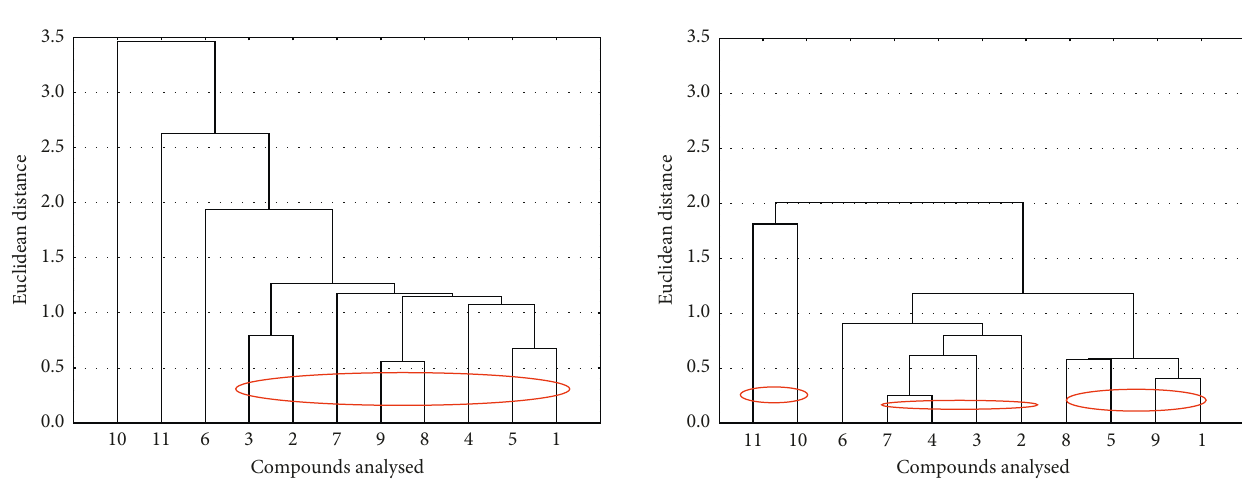
Figure 4: Similarity analysis for compounds investigated based on their values of biological